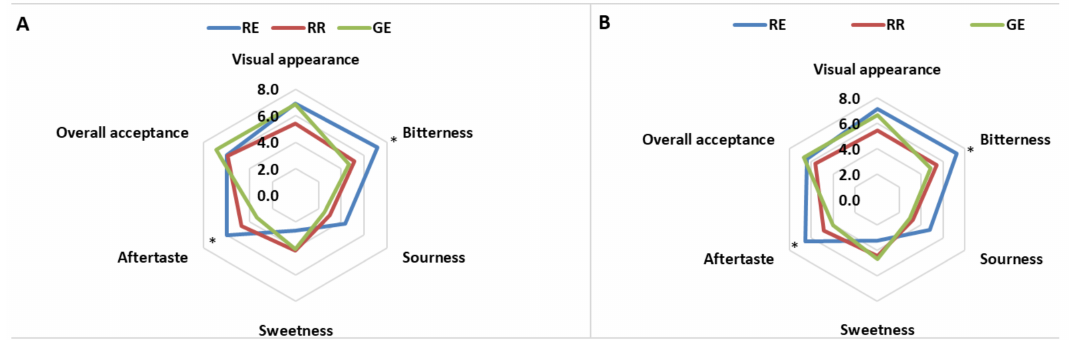
Figure 5. Sensory evaluation. ( A ) clustered data, ( B ) under 40 years old. Asterisks indicate significant